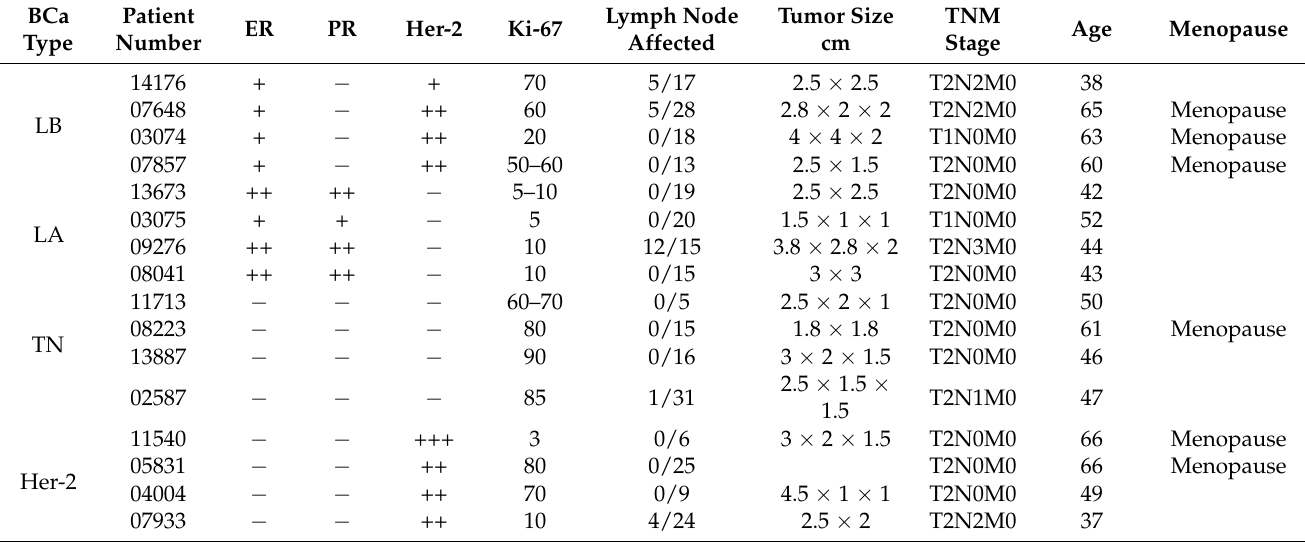
Table 1. Clinical and pathological characteristics according to breast carcinoma